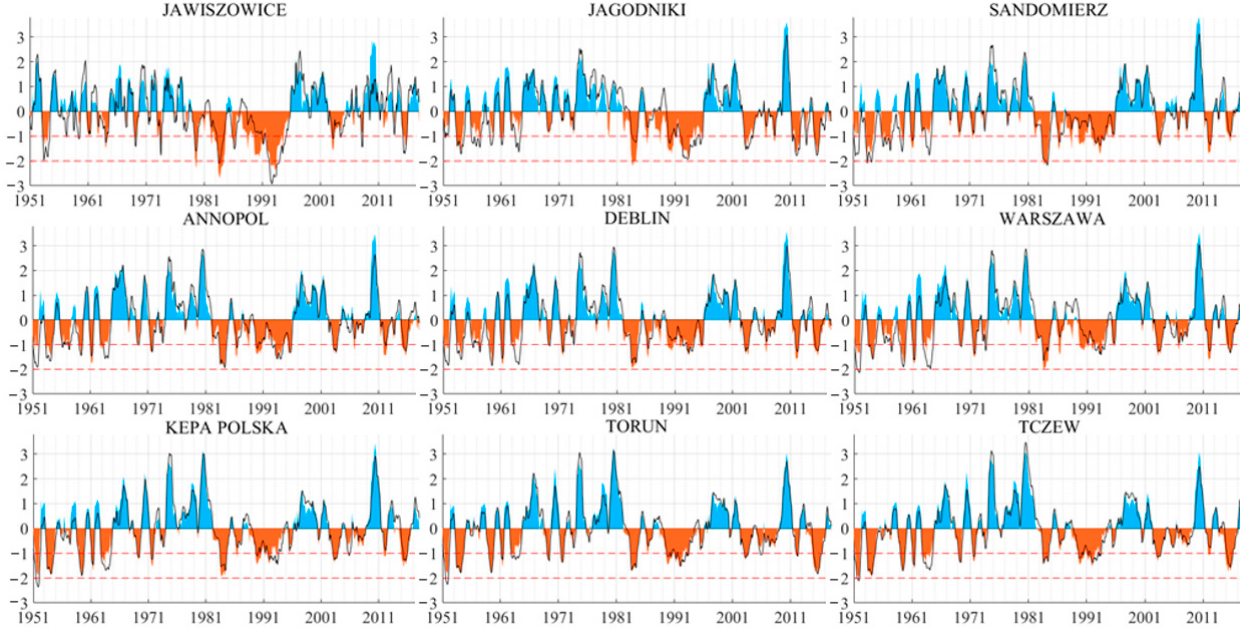
Figure 7. SSI12 (colored area) and SBFI12 (black line) indices for different gauging stations along the Vistula River (data from the 1 November 1950–31 October 2018 period).